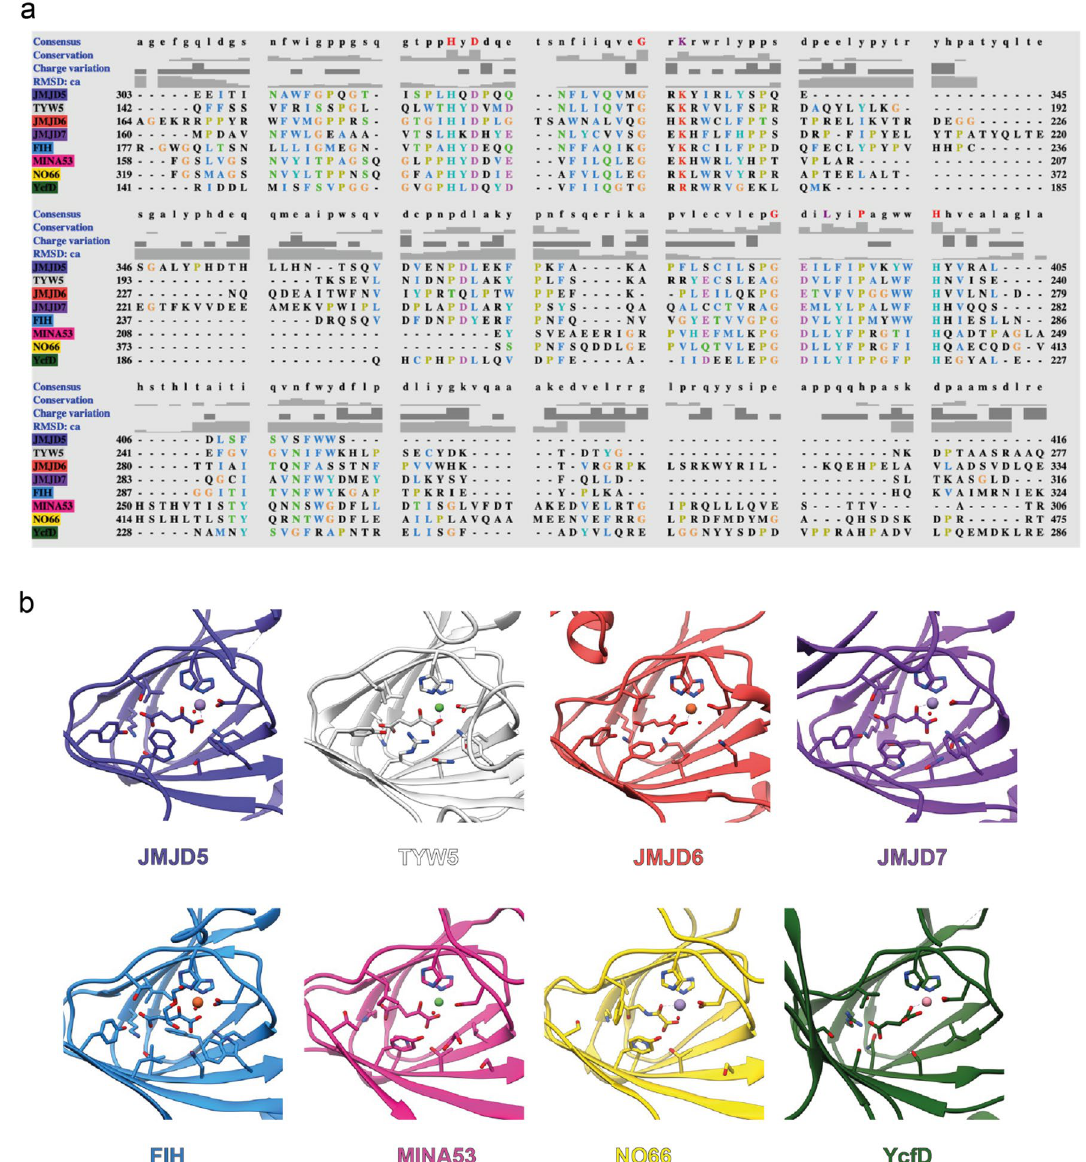
Figure 3. Ligand binding residues of JmjC hydroxylases. ( a ) Sequence-based alignment of JmjC domains of JMJD5 (UniProt-Q8N371), TYW5 (UniProt-A2RUC4), JMJD6 (UniProt-Q6NYC1), JMJD7 (UniProt- P0C870), FIH (UniProt-Q9NWT6), MINA53 (UniProt-Q8IUF8), NO66 (UniProt-Q9H6W3), and YcfD (UniProt-P27431) made using Clustal Omega in UCSF Chimera 76 . ( b ) Cartoon representation of the JmjC domain of 2OG hydroxylases with the ligand-binding residues in the site shown as sticks; JMJD5.Mn.2OG (PDB: 6F4N), TYW5.Ni.2OG (PDB: 3Al6), JMJD6.Fe.2OG (PDB: 6GDY), JMJD7.Mn.2OG (PDB: 5NFO), FIH.Fe.2OG (PDB: 4Z2W), MINA53.Ni.2OG (PDB: 4BU2), NO66.Mn.NOG (PDB: 4CCK), and YcfD.Co.2OG (PDB: 4LIT) . JMJD5 28 , MINA53 77 , NO66 77 are human ribosomal oxygenases, YcfD is a bacterial